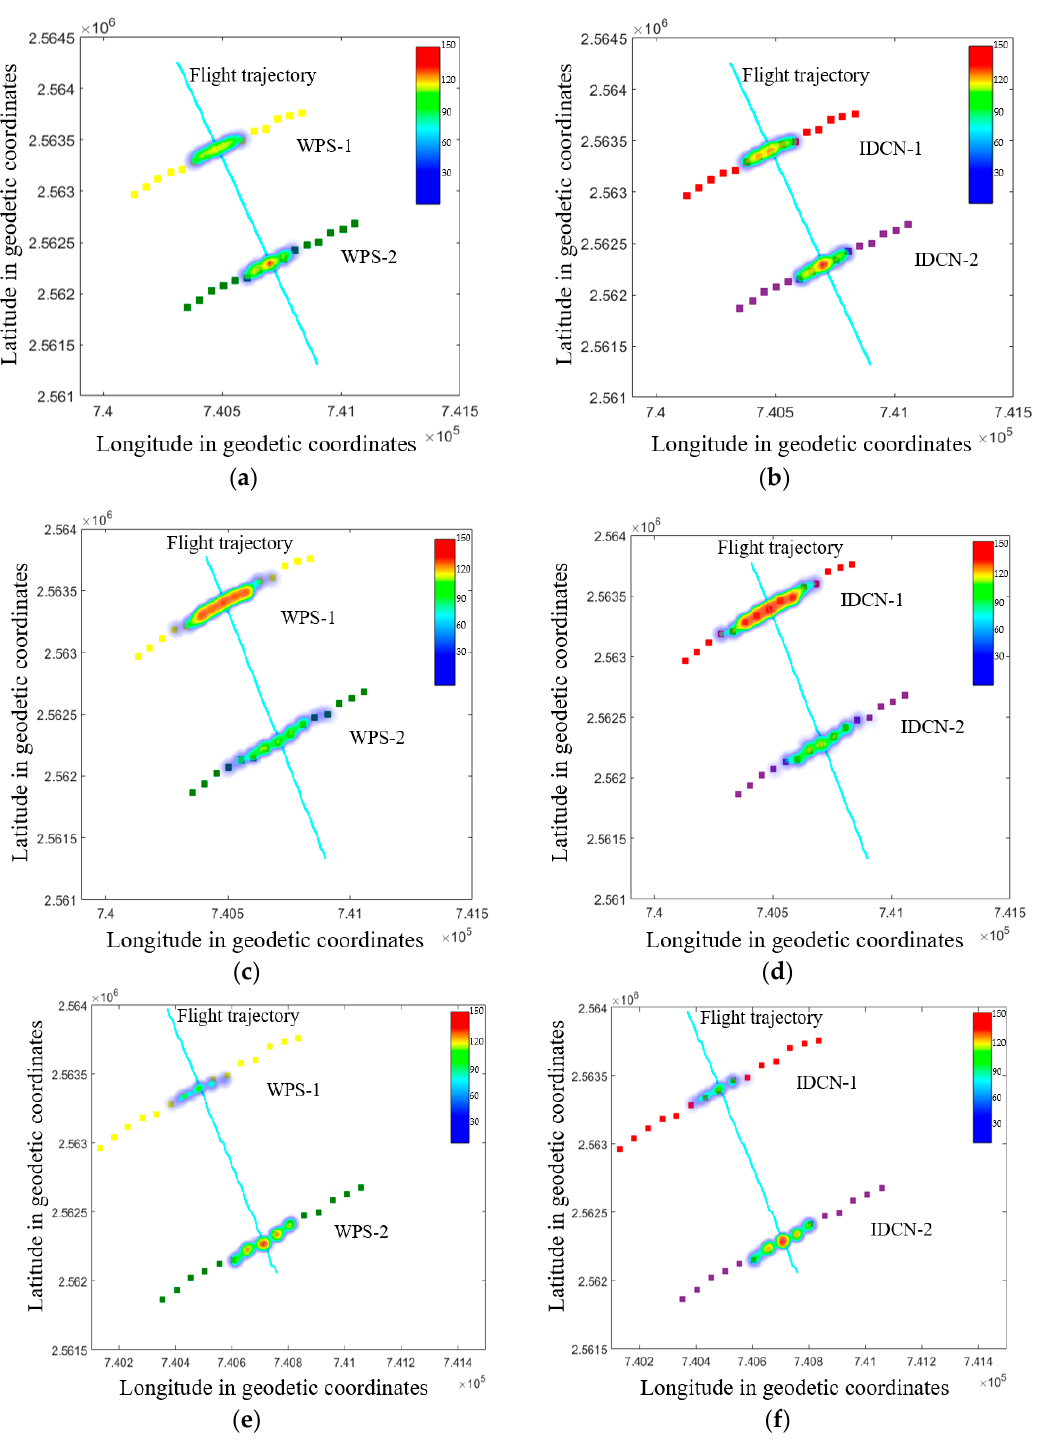
Figure 11. Heat map of droplet coverage density in each test. ( a ) Test1-WSP. ( b ) Test1- IDCN. ( c ) Test2-WSP. ( d )Test2- IDCN. ( e ) Test3-WSP. ( f ) Test3-